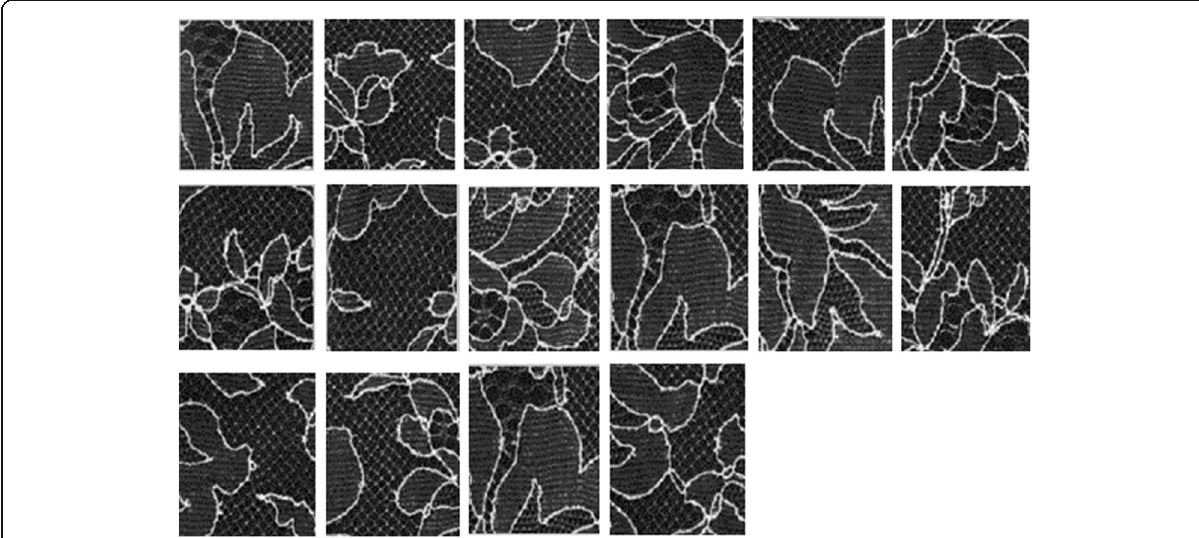
Fig. 7 Query results of a sample image from Brodatz database (top left is the query image and the remaining are the retrieved results). For a sample query image from Brodatz database, the top matching images retrieved from the database are shown in the image